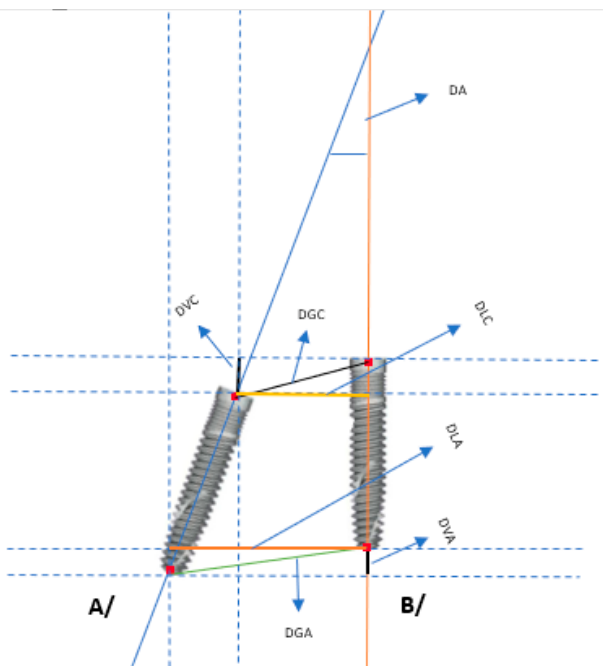
Figure 4. Deviations between planned and final implant position. A/ = actual implant position; B/ = planned implant position; AD = angular deviation; AGD = apical global deviation; CGD = coronal global deviation; ALD = apical lateral deviation; CLD = coronal lateral deviation; AVD = apical vertical deviation; CVD = coronal vertical deviation.